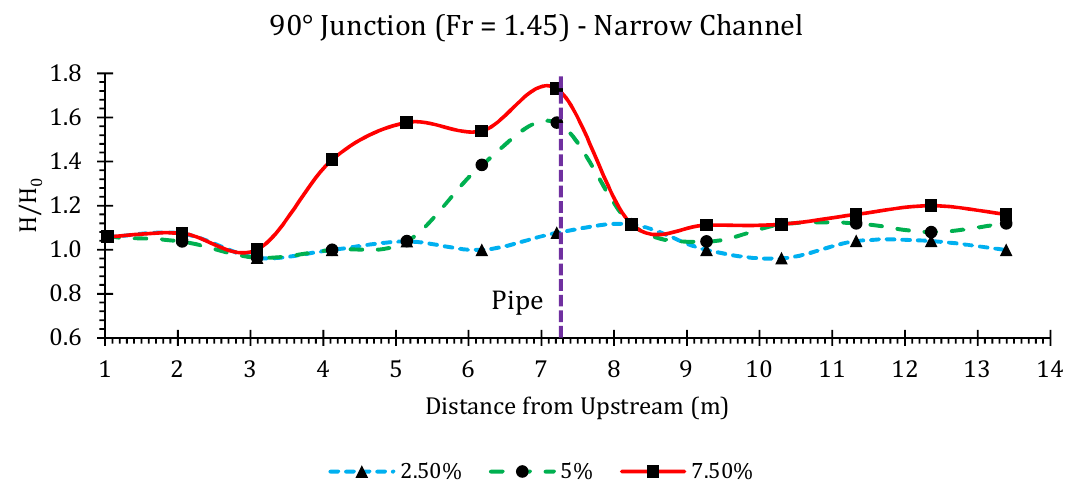
Figure A30. Water height ratios in a 90° junction for Fr = 1.45 in the narrow channel.